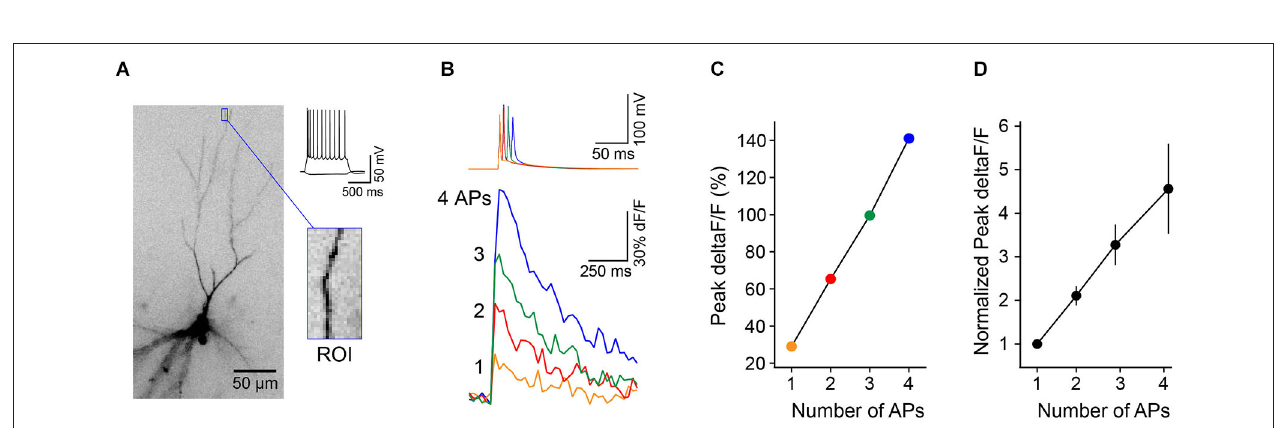
FIGURE 2 | Simulations consistently predict branch specific inhibition in different L3 pyramidal cells (PCs) . Results from anatomical reconstructions of four additional cell pairs (as in Figure 1 ) showing dendritic morphology of